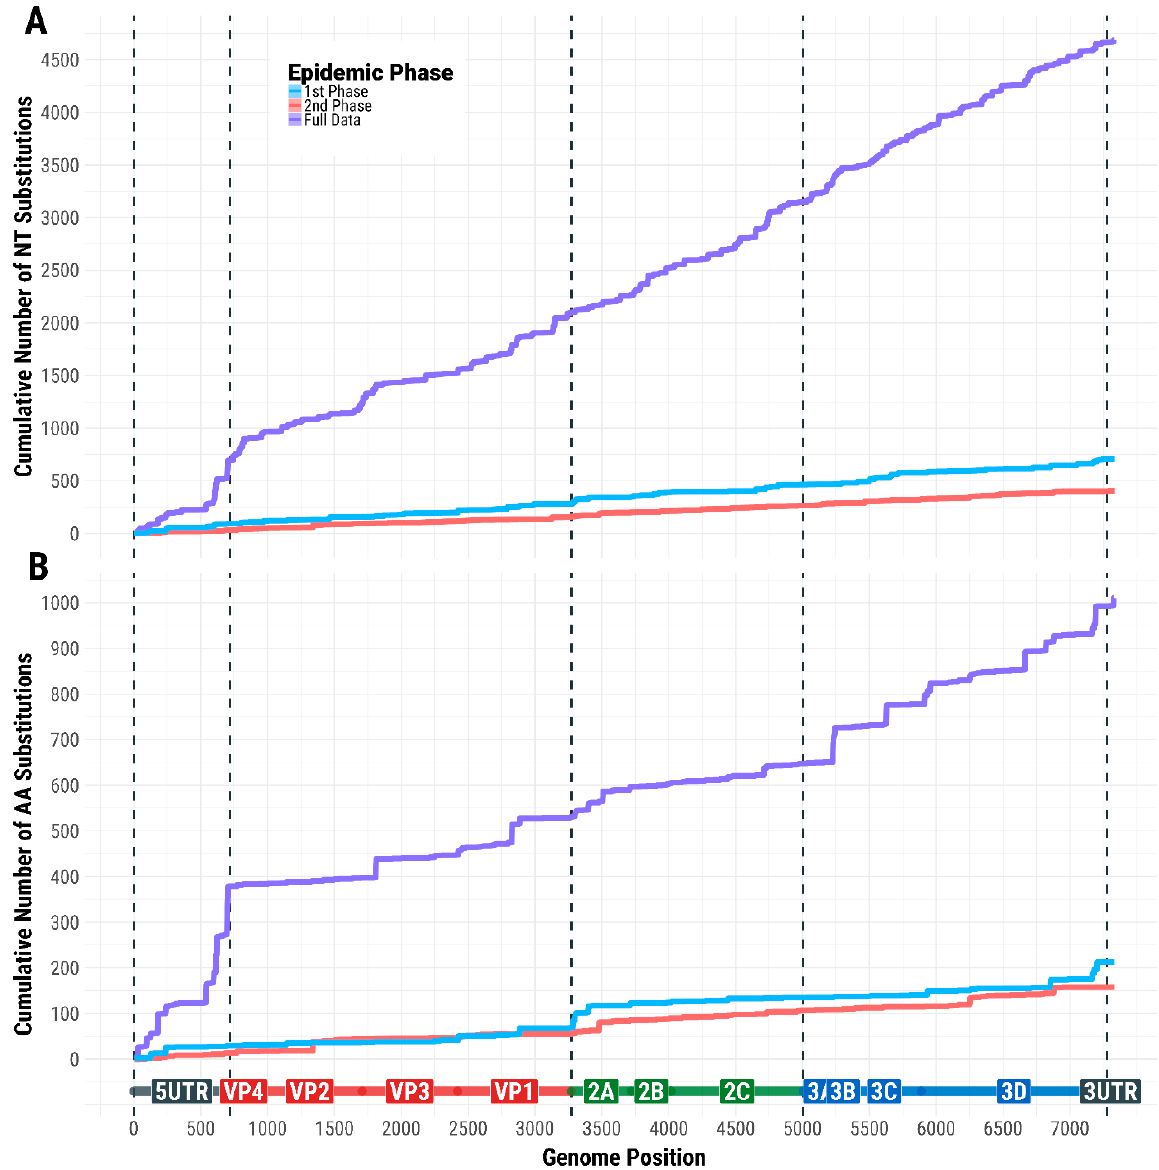
Figure 7. Nucleotide and amino acid substitutions occurring along the SVDV genome during the 2006–2007 SVD epidemic in Italy. ( A ) Distribution of the cumulative number of nt substitutions across the different genomic regions of SVDV; ( B ) distribution of the cumulative number of amino acid substitutions across the different genomic regions of SVDV.